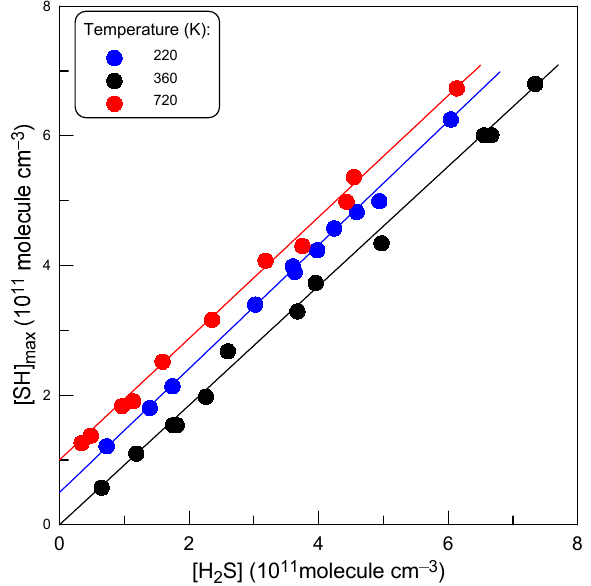
Figure 6. Typical dependence of [SH] max on [H 2 S] (see text). For clarity, the experimental points at T = 220 and 720 K are Y-shifted by 0.5 and 1, respectively. Table 2. Experimental conditions and results of the measurements of the rate coefficient of Reaction (2). T (K) a [H 2 S] 0 b